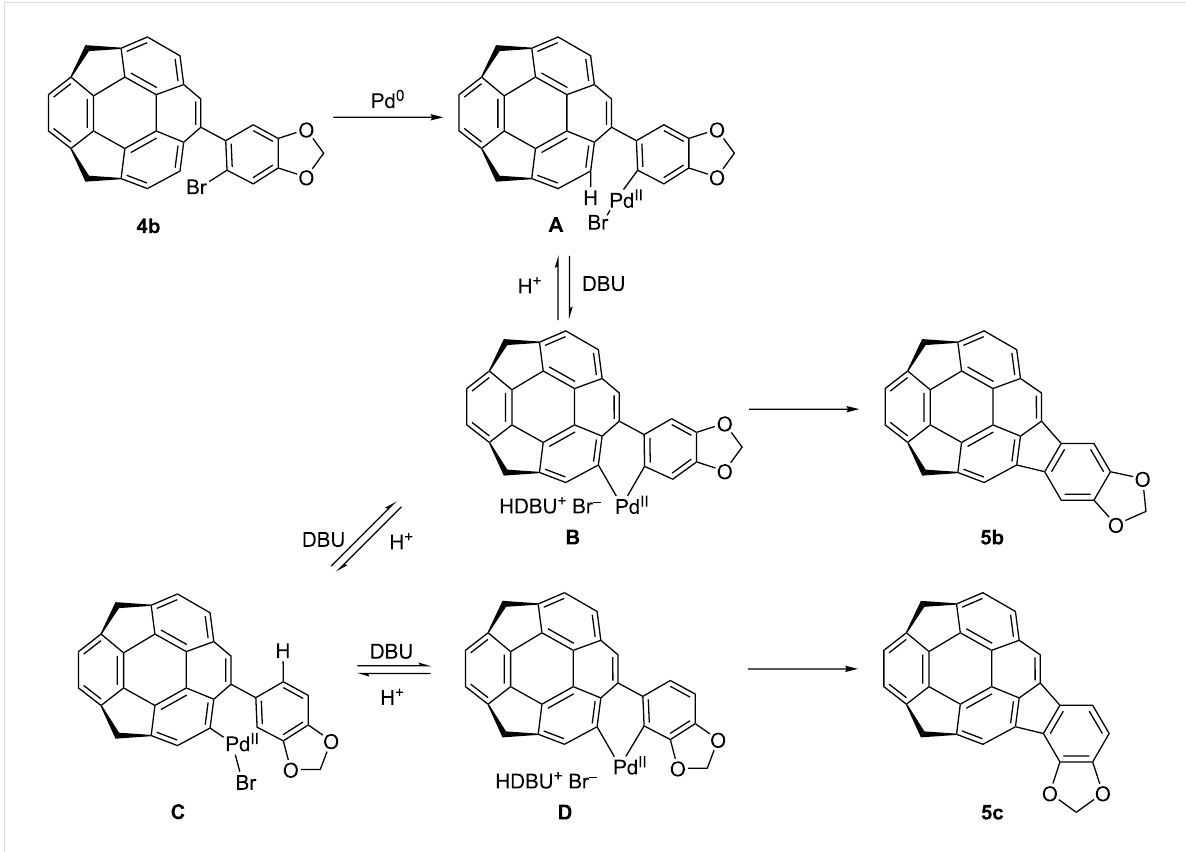
Scheme 2: Proposed mechanism of the formation of 5b and 5c .